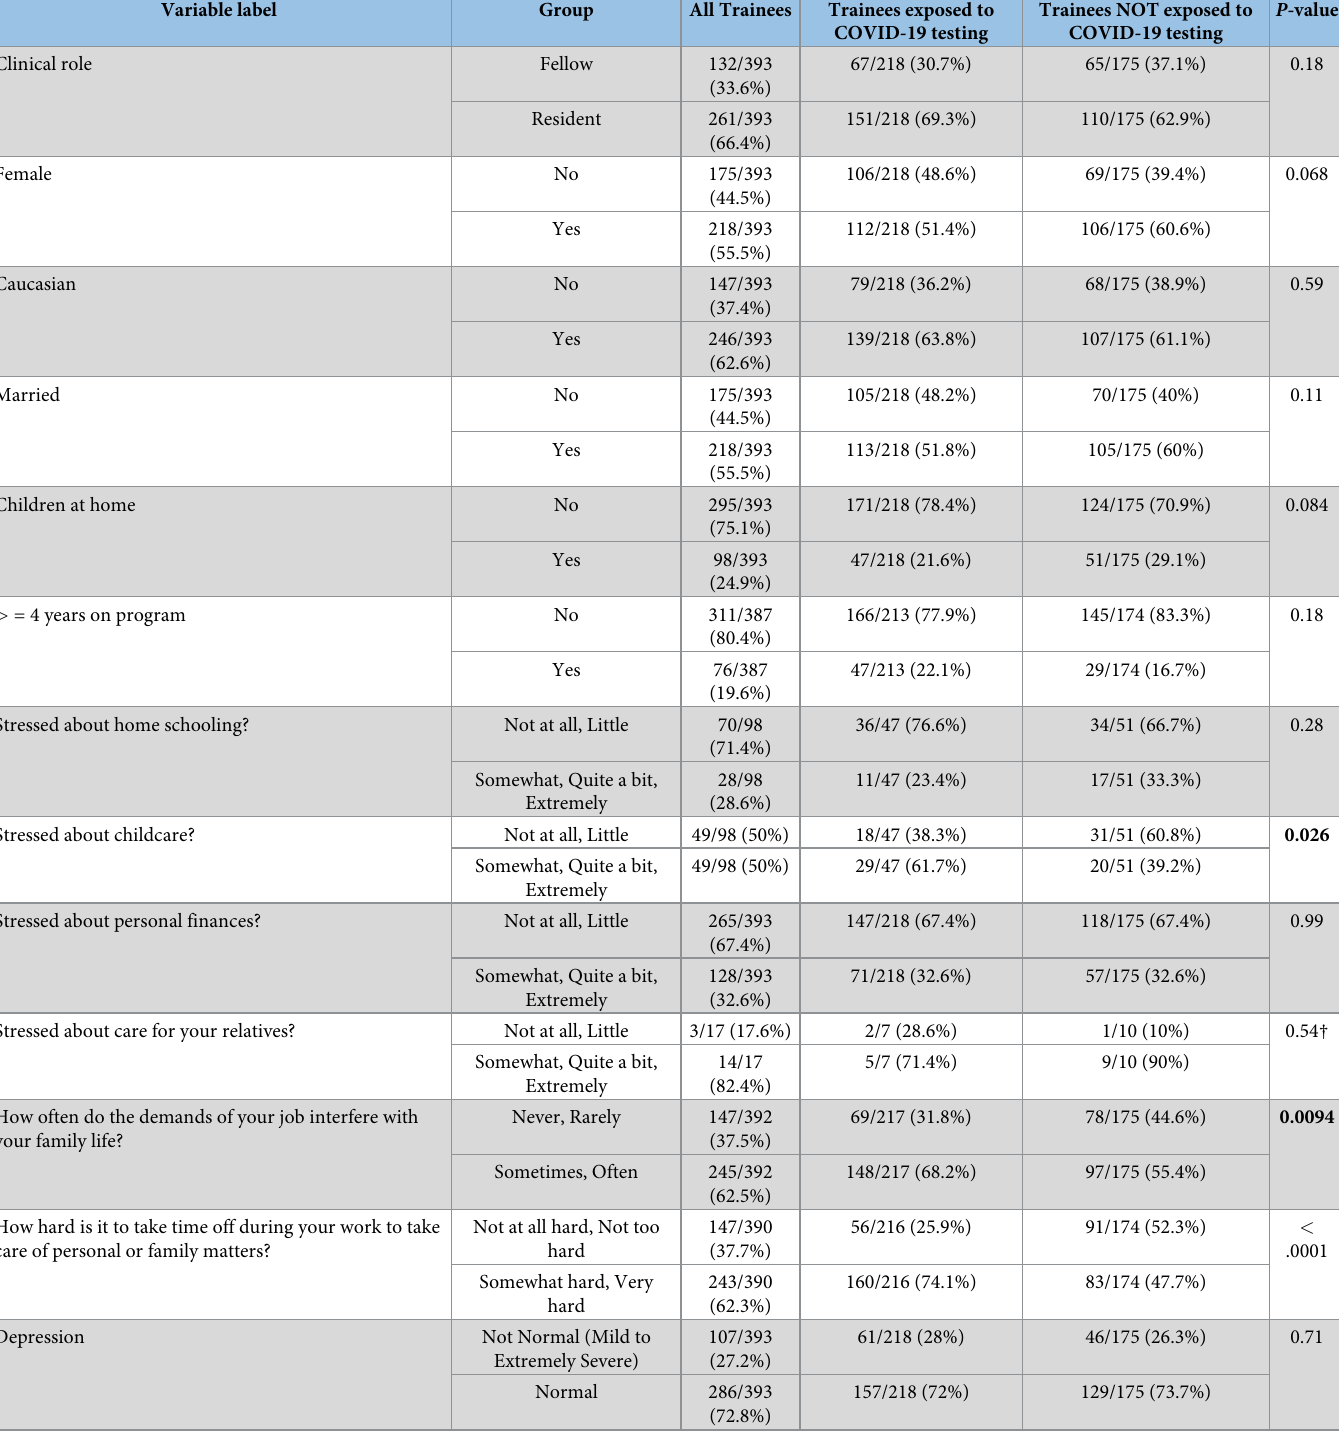
Table 1. Summary descriptive table of the considered variables in the survey separated into trainees exposed to patients being tested for COVID-19 and trainees not exposed to such